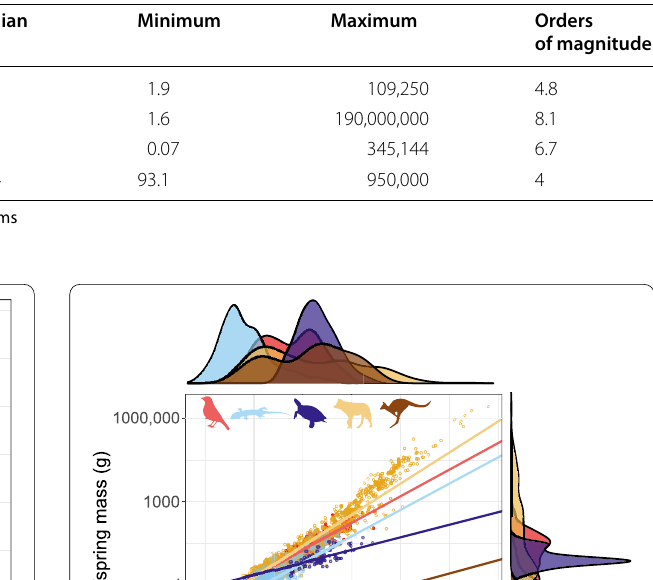
Table 1 Body masses of amniotes (g)